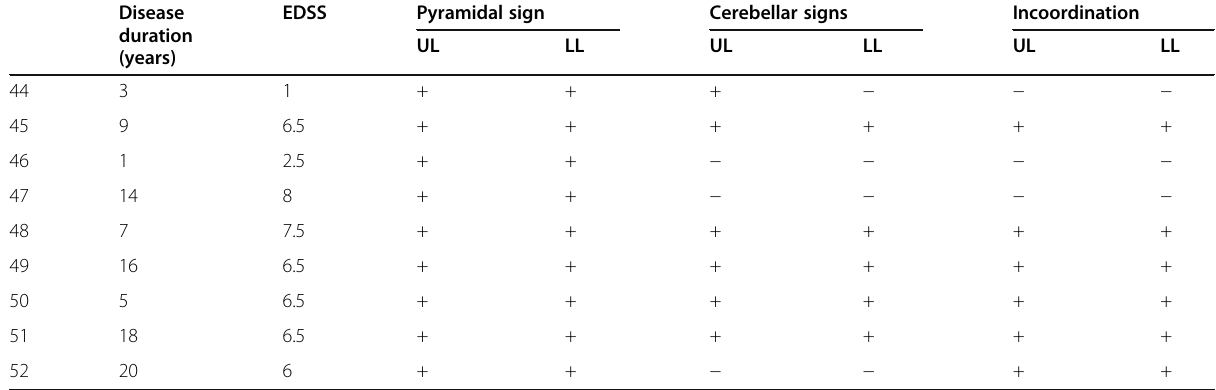
“ − ” indicates negative, and “ + ” positive